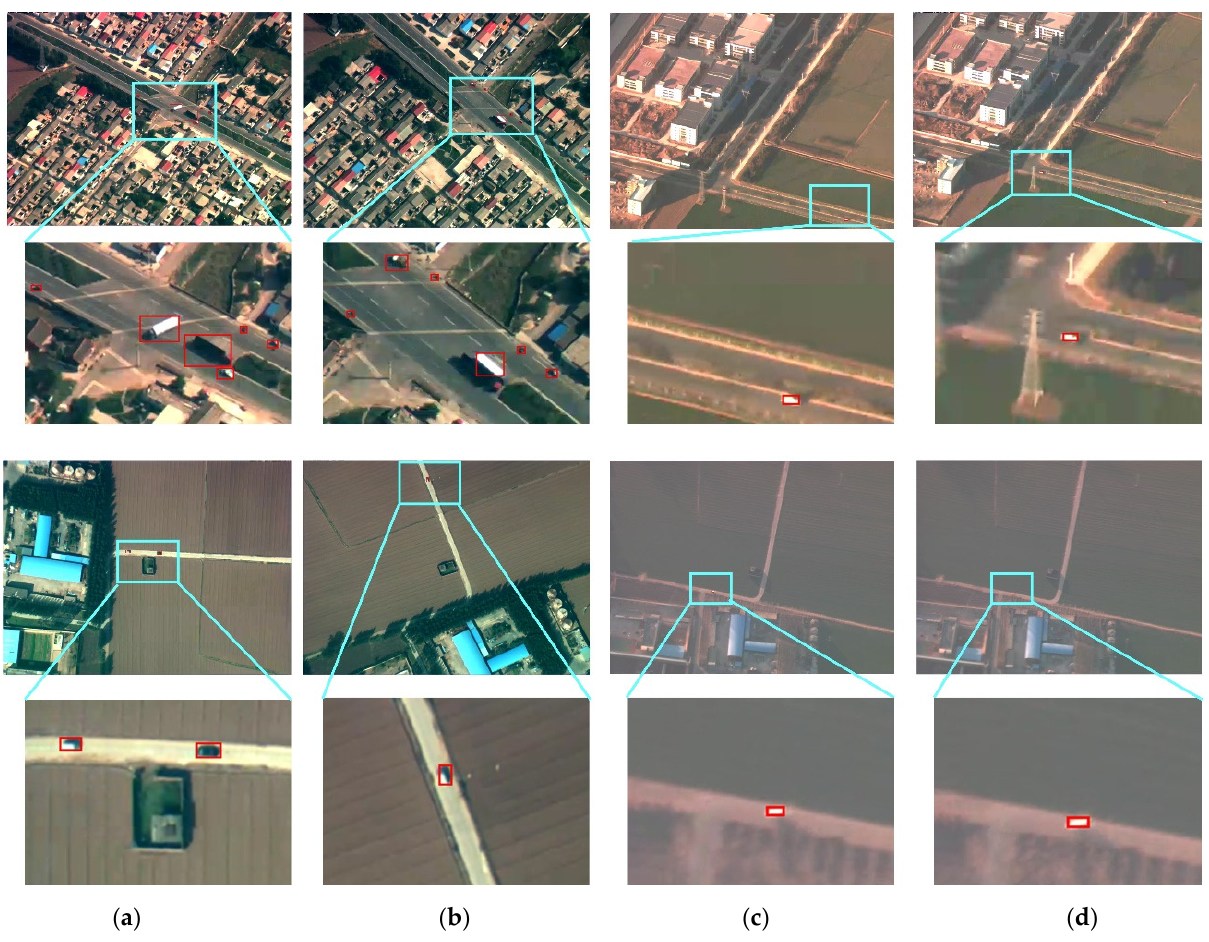
Figure 5. Visualization results of vehicle detection. ( a , c ) Lines show UAV images in different scenes. Part of the original image (cyan area) is enlarged and displayed in ( b , d ) lines accordingly to display the detection details.